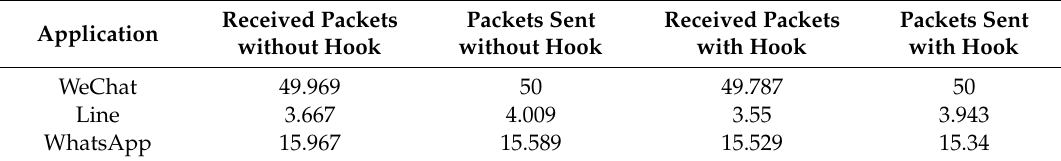
Table 2. Performance on three social apps.